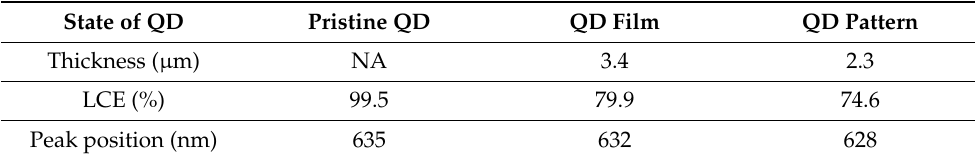
Table 3. Thickness and optical performance of QD, QD film and QD pattern. State of